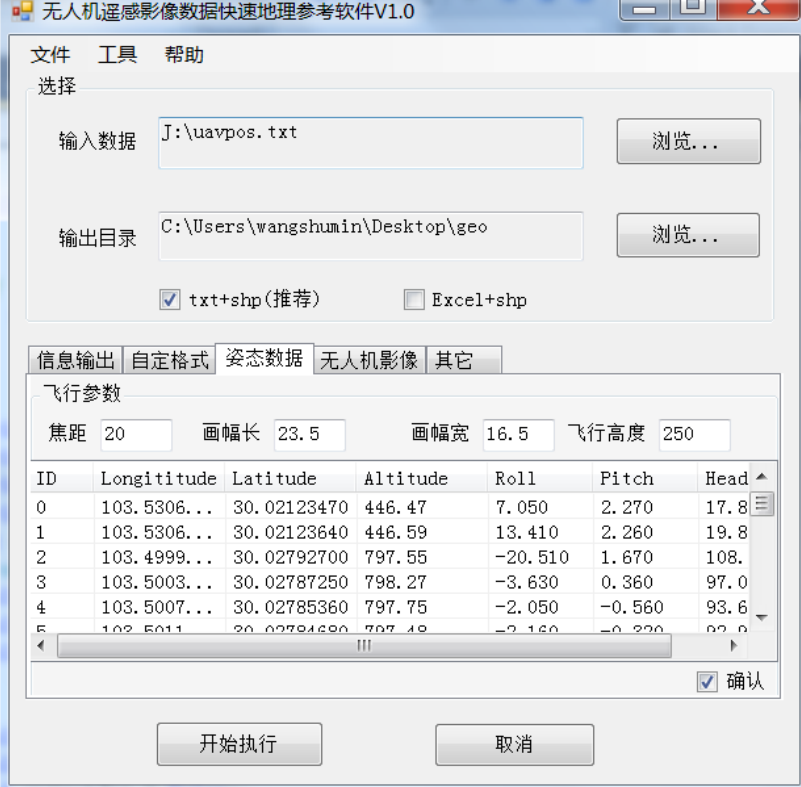
Figure.2 The interface of the rapid geographical reference software